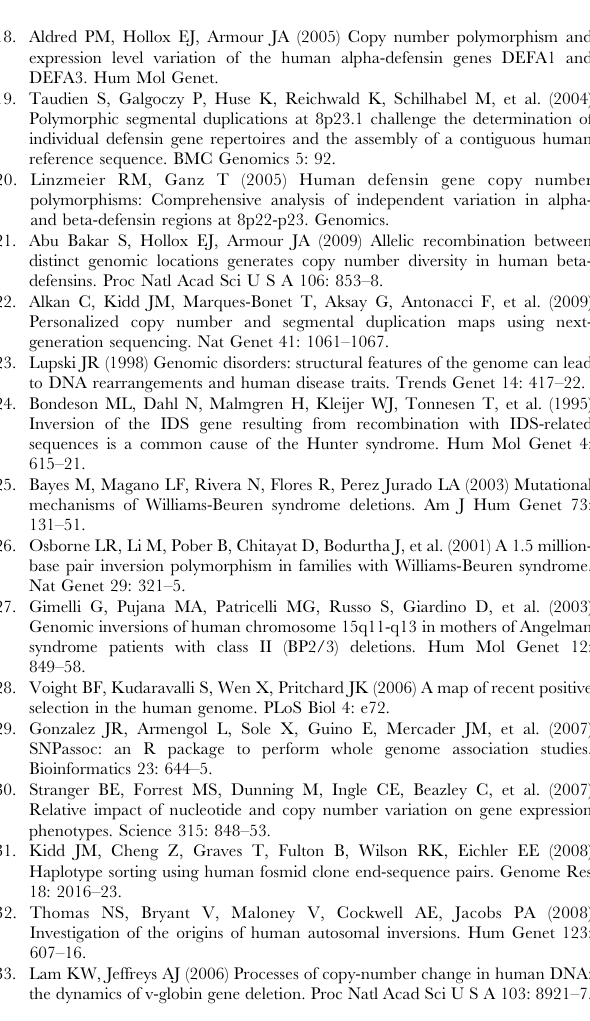
Figure S1 FISH analysis of the human chromosome 8p23.1 inversion in HapMap samples. Metaphase FISH of three HapMap individuals, NA12057 as an example of non-inverted individual; NA06993 is heterozygous for the 8p23.1 inversion and NA12815 corresponds to a homozygous inverted individual. Figure S2 Scheme of the different sizes of 8p23.1 inversion within nine human cell lines as a result of fosmid-end cloning and sequencing. For each cell line fosmid library (ABC7 to G248) several end-sequenced fosmid clones were discordant for the mapping of the end sequences, showing an inversion with respect to the reference genome, and also showing different mapping positions. The abundance of each fosmid clone and the approximate sizes of the rearrangements are shown in Supple- mentary Table 1 (data extracted from Kidd et al., 2008). The filed orange-yelow boxes correspond to the segmental duplications (SD)